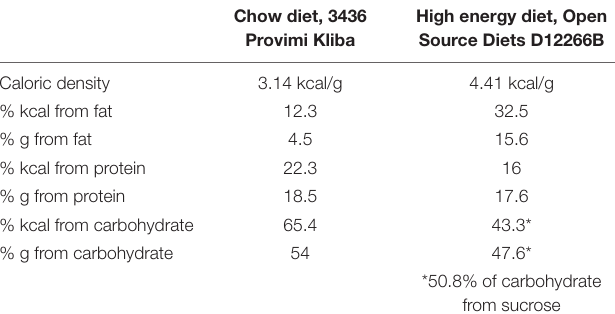
TABLE 1 | Macronutrient composition of experimental rodent